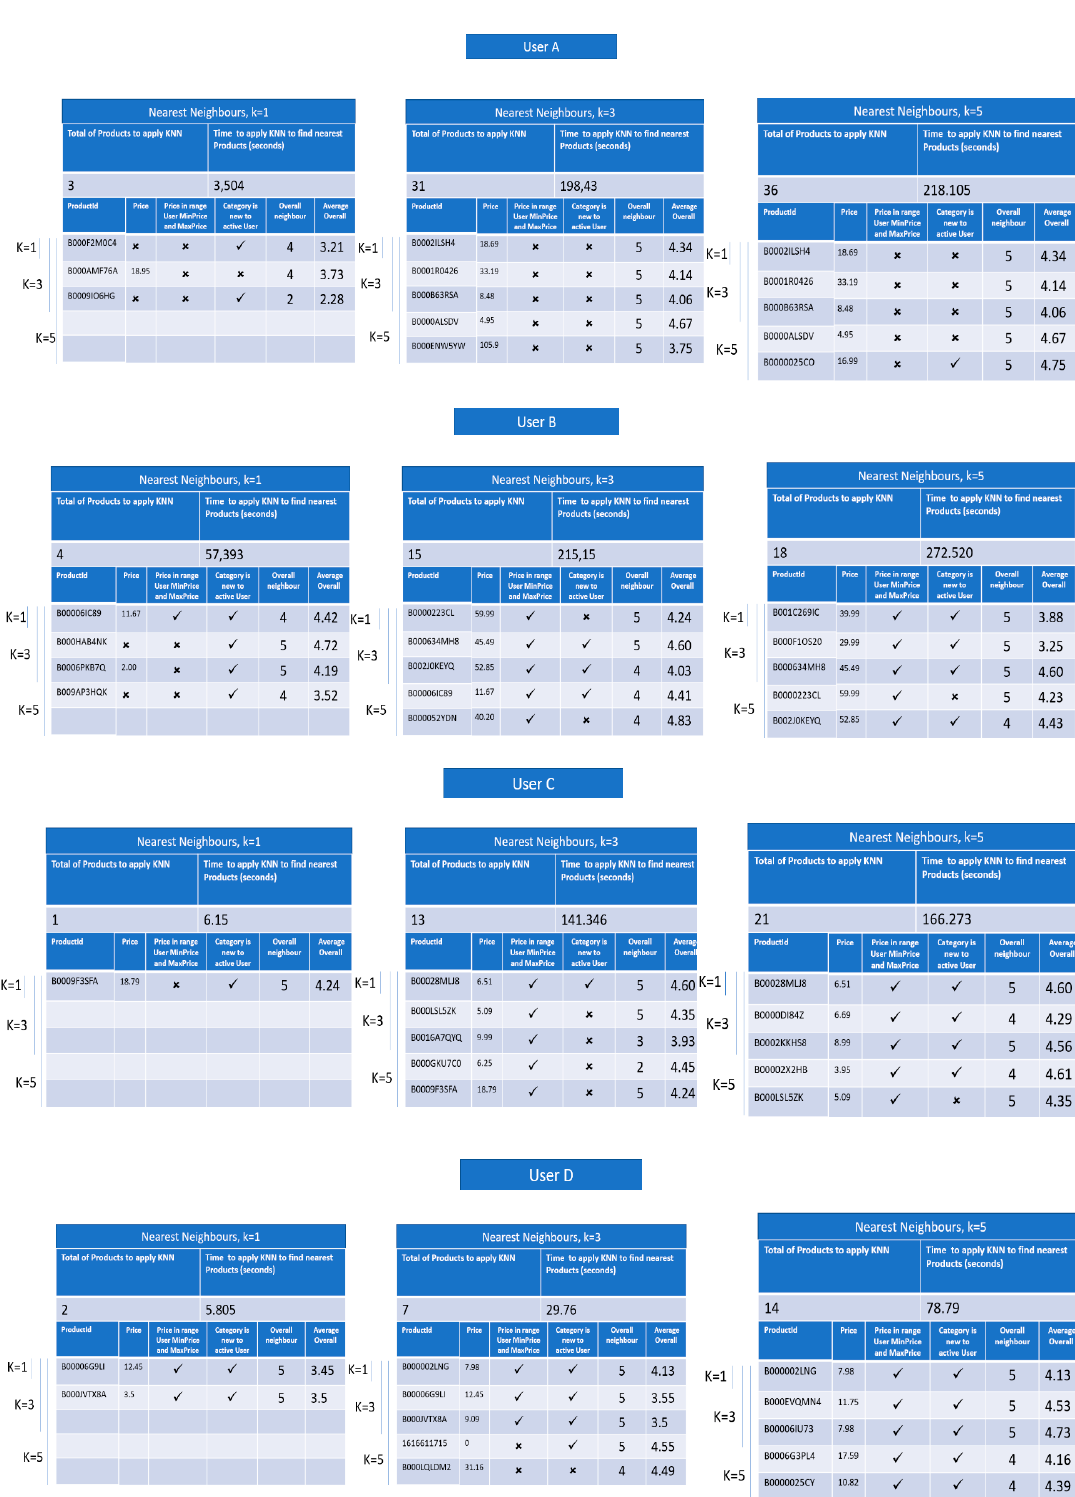
Figure 6. Version A of the recommendation system, and Products recommend to each active User .